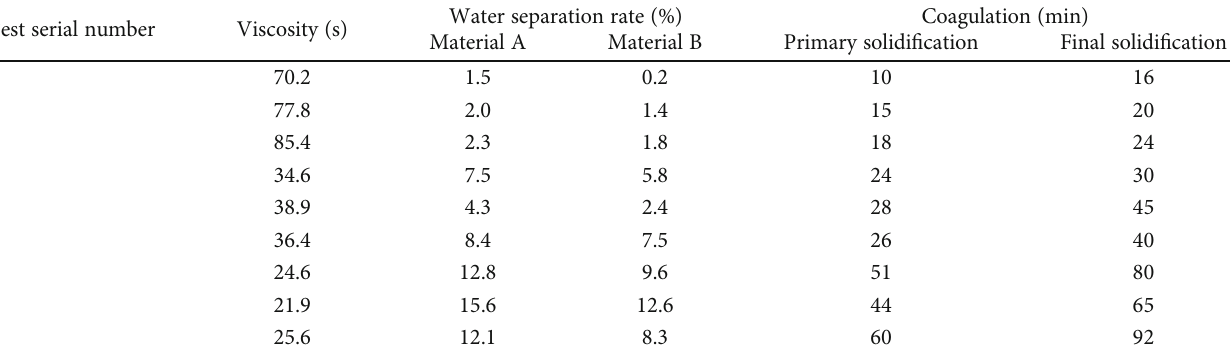
Table 3: Physical property test results.